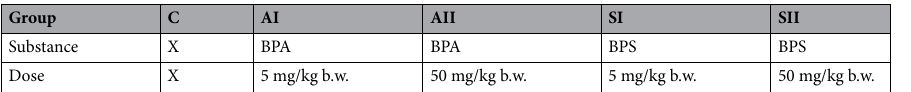
Table 2. Description of groups (dose and type of administrated substance) of animals used in the study. BPA bisphenol A, BPS bisphenol S, C control, b.w. body weight.